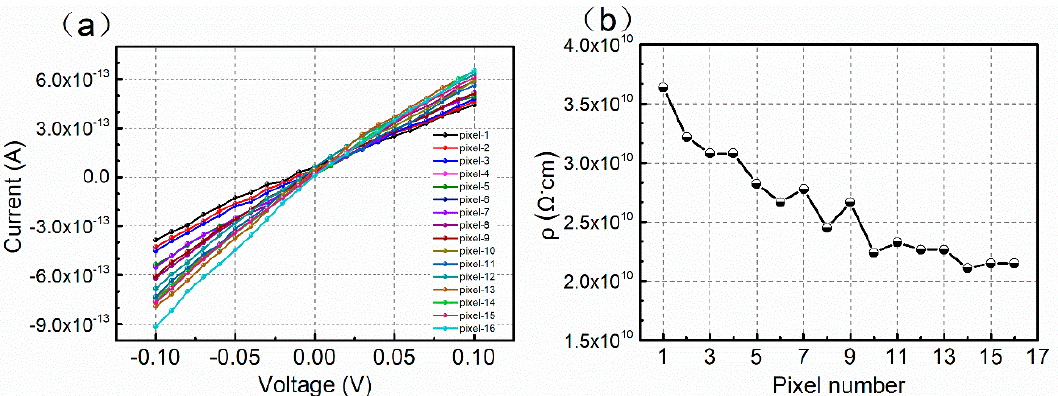
Figure 3. ( a ) Current–voltage (I–V) curves for the 16 pixel regions of the CdZnTe photon counting detector; ( b ) trend of resistivity of the 16 pixels.